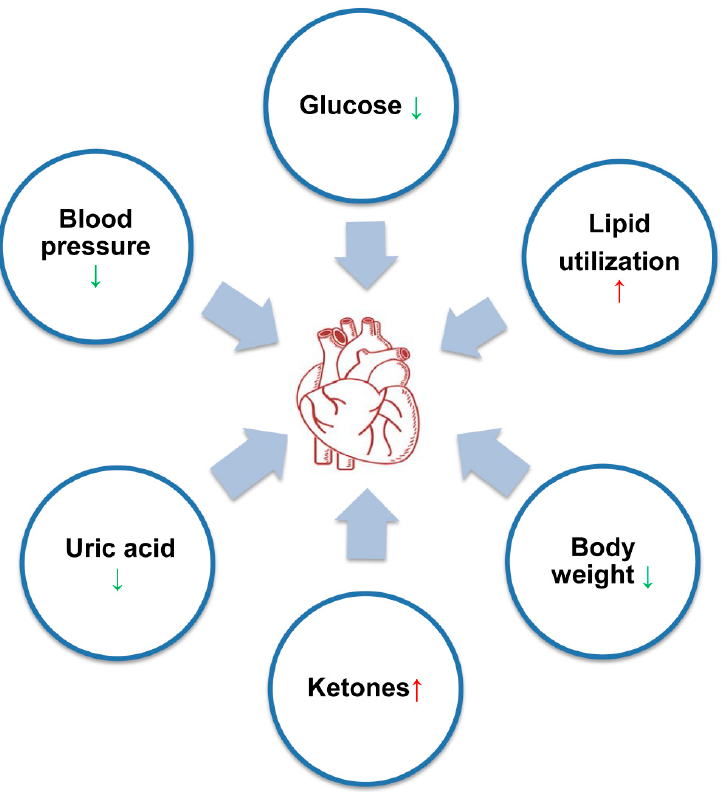
Figure 2. Improvements of some CVD-related clinical indicators by SGLT2 inhibitors. SGLT2 inhibitors not only reduce high glucose independent of insulin but also improve blood pressure, body weight, lipid profile and ketones and uric acid to present cardioprotective effects; ↑ , increase; ↓ , decrease.